Question: Express in one sentence what the figure is showing.
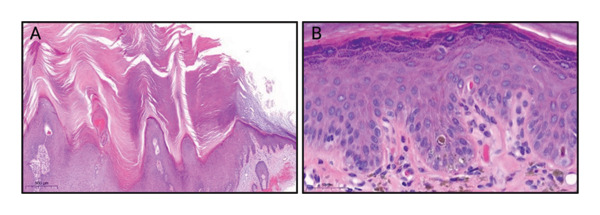
Answer: Histopathologic findings. (A) Histopathologic findings of endophytic verruca vulgaris on left calf. There is hyperkeratosis, acanthosis, and papillomatosis (hematoxylin & eosin stain, magnification 3x). (B) Histopathologic findings of acral junctional melanocytic nevus on left palmar surface. There are small, discrete nests of monomorphic melanocytes at the dermoepidermal junction with minimal pagetoid scatter of melanocytes, papillary dermis with many melanophages, and discrete, thin columns of melanin in the cornified layer (hematoxylin & eosin stain, magnification 40x).